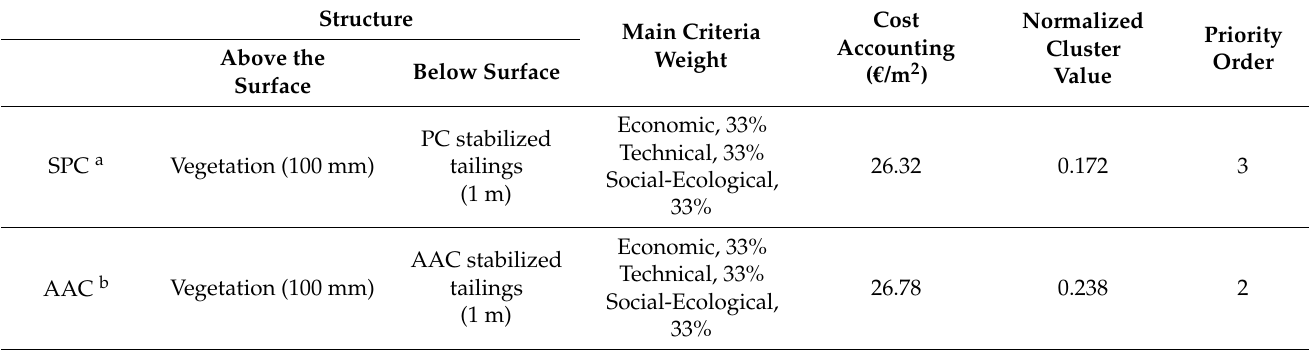
Figure 6. Schematic diagram of geopolymer reaction [64]. This picture was adapted from [64] with permission from publisher Elsevier in 2021. Table 1. Multiple-criteria decision analysis of solidification/stabilization cover scheme [65]. This picture was adapted from [65] with permission from publisher Elsevier in 10 May